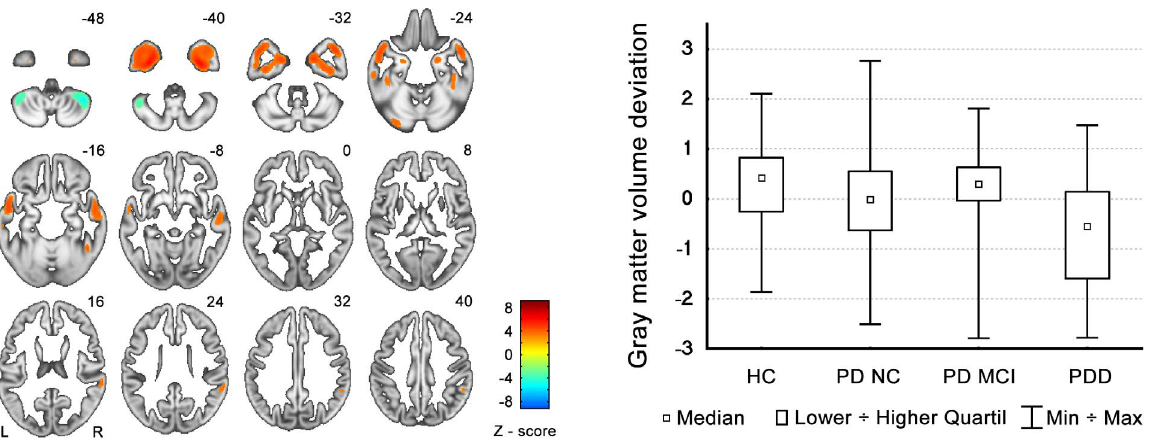
Figure 1. C1 component pattern and GMV changes in individual groups. The graph shows the deviations from the all-participants’ mean. GMV decreases are depicted by red color and GMV increases are in green. The box graph on the right side shows median GMV changes in individual